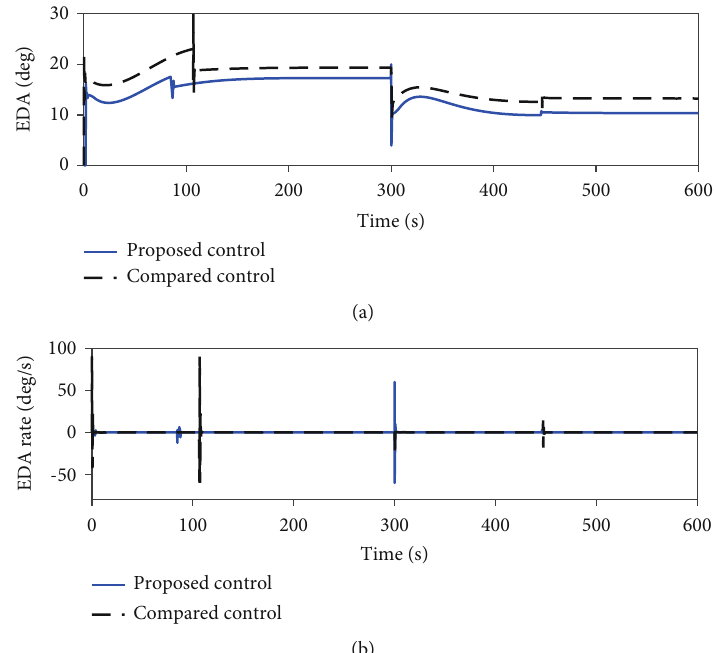
Figure 7: EDA and EDA rate in the comparison simulation: (a) elevator de fl ection angle; (b) elevator de fl ection angle rate.